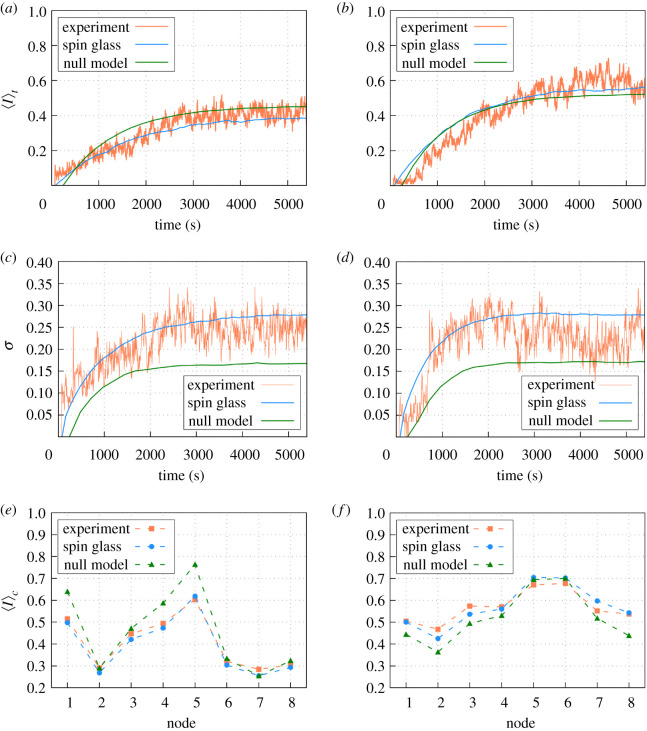
Averaged daily occupancy dynamics 〈I〉t for the spin-glass approach (with and without pairwise interactions) and experimental data during (a) regime A and (b) regime B. The corresponding standard deviations are also shown for (c) regime A and (d) regime B. Averaged occupancy in the stationary regime 〈I〉c for the spin-glass approach and experimental data during (e) regime A and (f) regime B. For more information of the relationship between the MC step and the real time, see appendix B. The deviation of 〈I〉c obtained from the models to the experimental one is computed from the variance of the departures from one to the other: (e) we find (σSG2=0.0004 and σJ=02=0.0065), and (f) (σSG2=0.0011 and σJ=02=0.0025). In both regimes, the spin-glass model shows smaller departures from the experiment than the null model. In addition, an analysis of variance (ANOVA) test with α = 0.05 for null differences with the experimental data leads to p-value = 0.80 (spin-glass) and p-value = 0.54 (null model) for regime A, and p-value = 0.96 (spin-glass) and p-value = 0.37 (null model) for regime B.